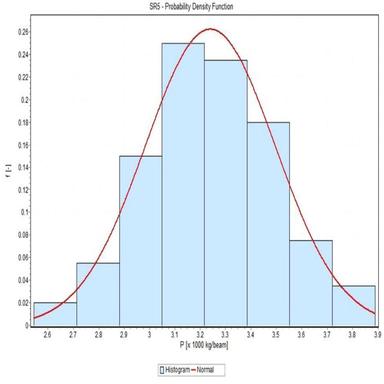
Histogram of system strength for: a) Rack frame SR5 and b) Rack Frame SR3wD.